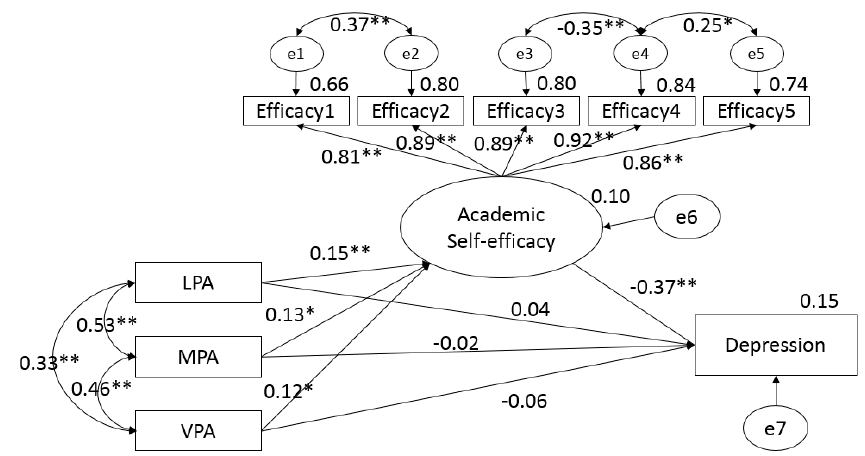
= light physical activity, MPA =